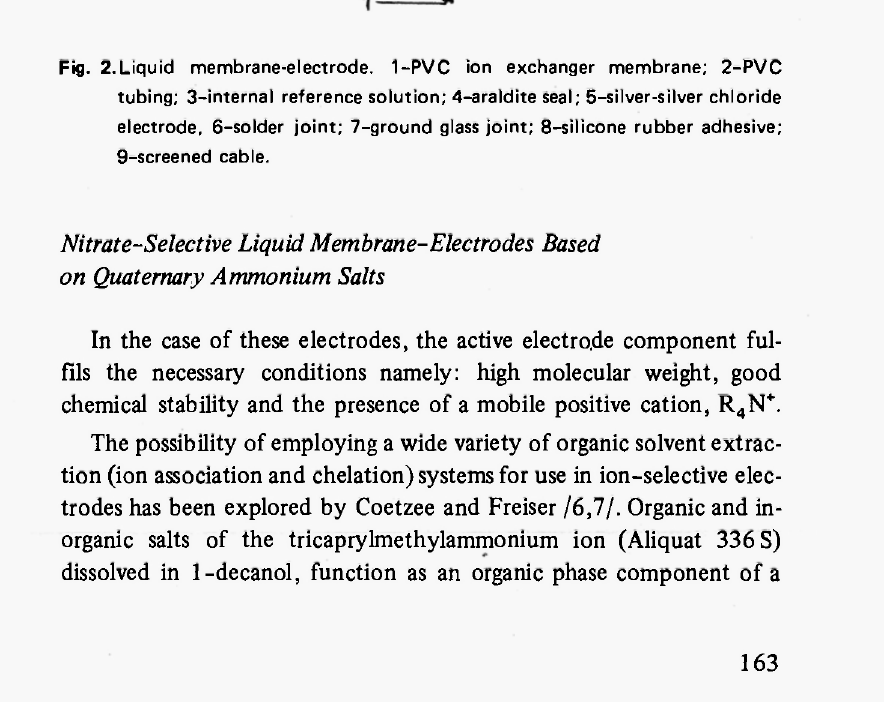
Fig· 2.Liquid membrane-electrode. 1-PVC ion exchanger membrane; 2-PVC tubing; 3-internal reference solution; 4-araldite seal; 5-silver-silver chloride electrode, 6-solder joint; 7-ground glass joint; 8-silicone rubber adhesive; 9-screened